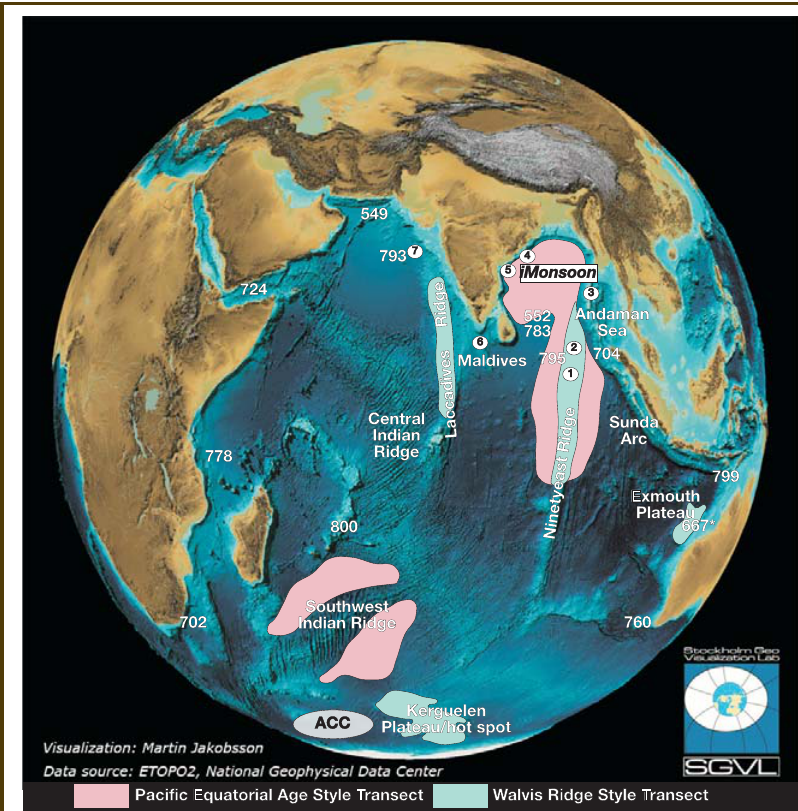
Figure 1. Pre-existing proposals and future drilling prospects in the Indian Ocean. Potential Theme 1 targets include two types of deep ocean transects; ACC=Antarctic Circumpolar Current drifts proposal; Maldives atoll & deep-water proposals. Theme 2 targets include iMonsoon program with locations: 1) DSDP 216, 2) ODP 758, 3) Andaman